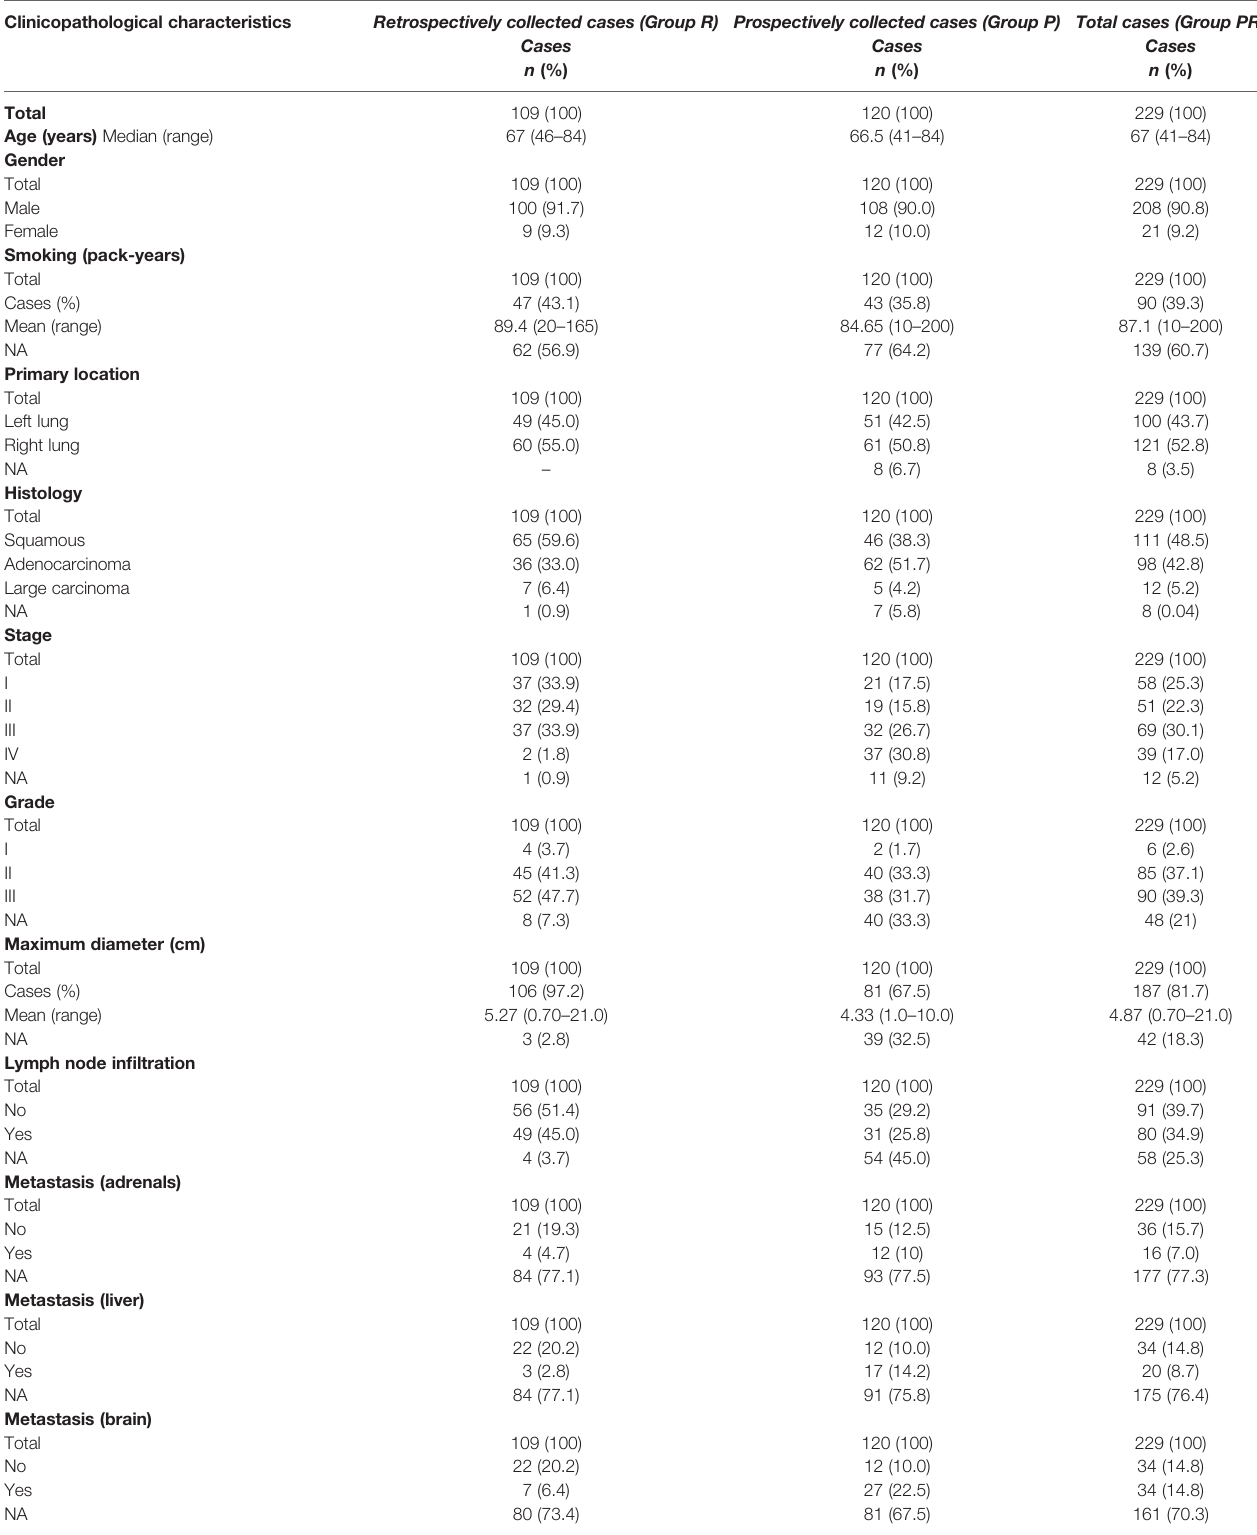
TABLE 1 | Clinicopathological characteristics of patients of this study. Clinicopathological